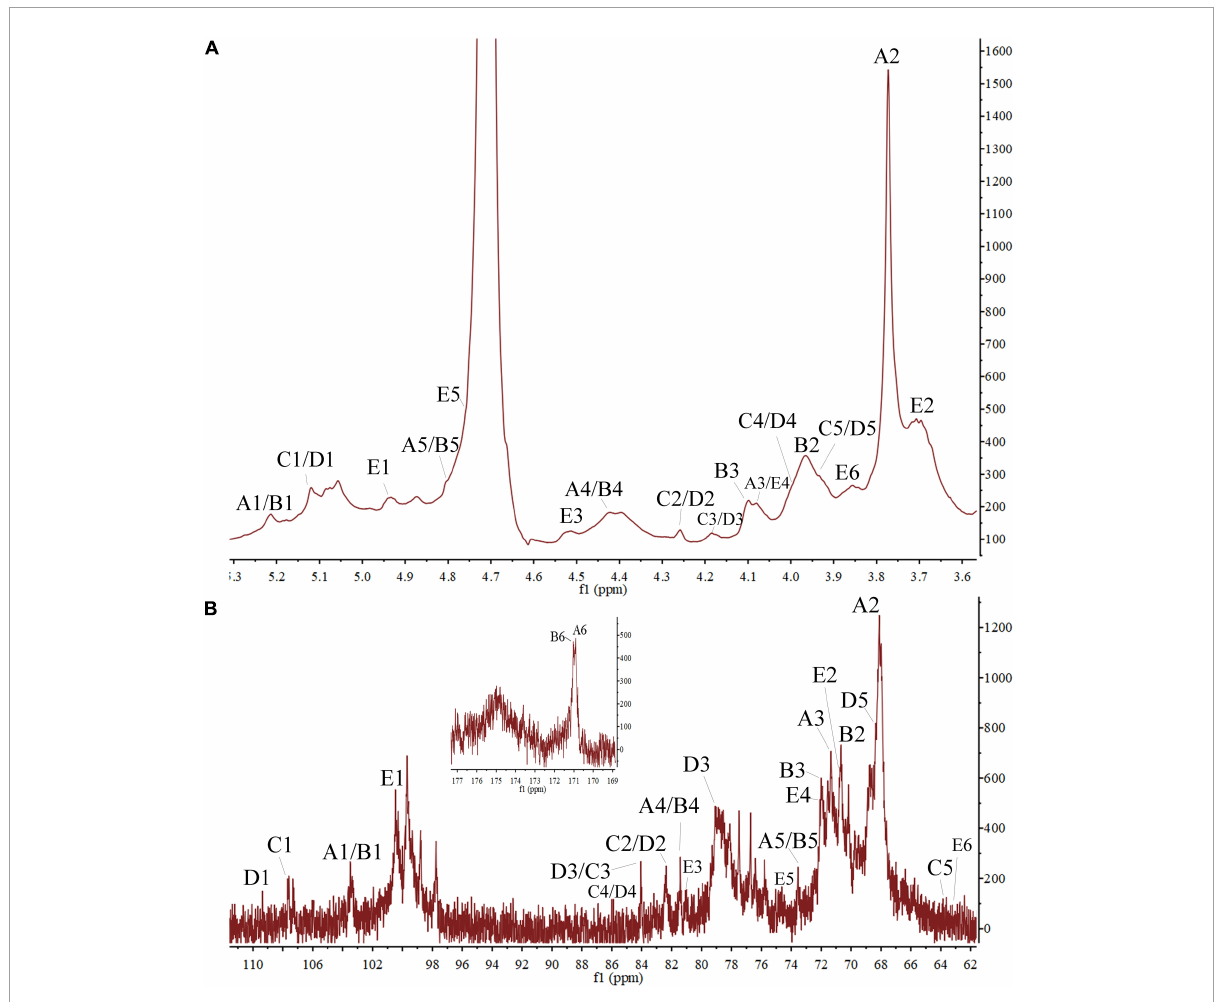
FIGURE3 The PZMP3-1’s nuclear magnetic resonance spectroscopy (NMR) spectra in D 2 O. (A) 1 H spectrum. (B) 13 C